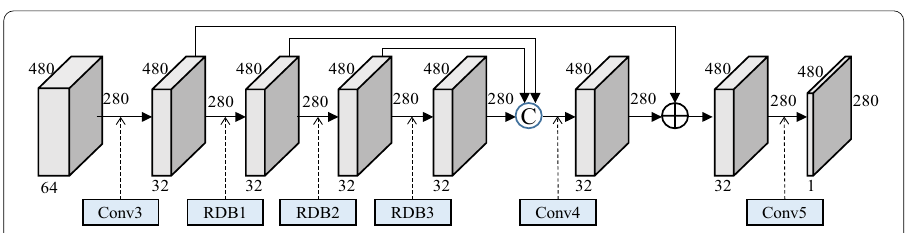
Fig. 7 Sketch diagram of depth refinement